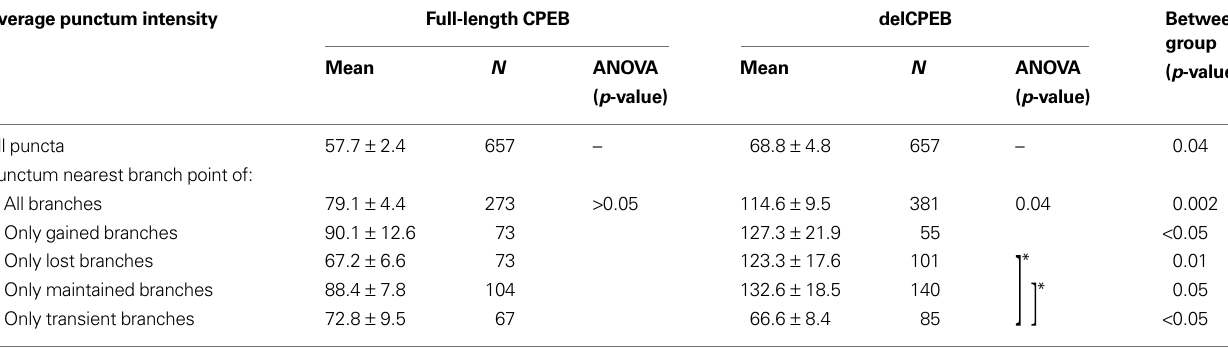
Table 3 | Punctum intensity in the different terminal branches. Average punctum intensity